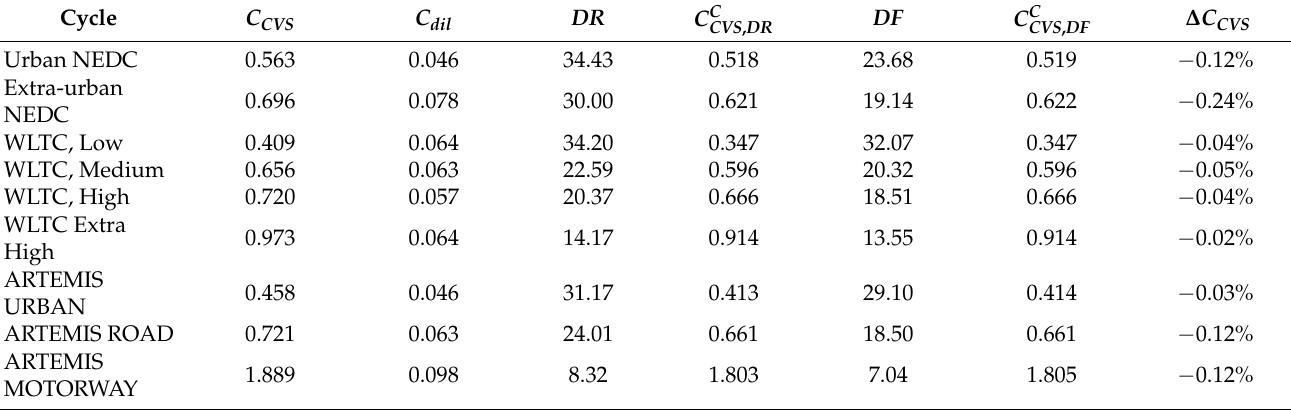
Table A11. The C CVS,corr calculated based on Equations (5) and (21) for Euro 6 WLTP vehicle with SI engine, CO 2 concentration [%].